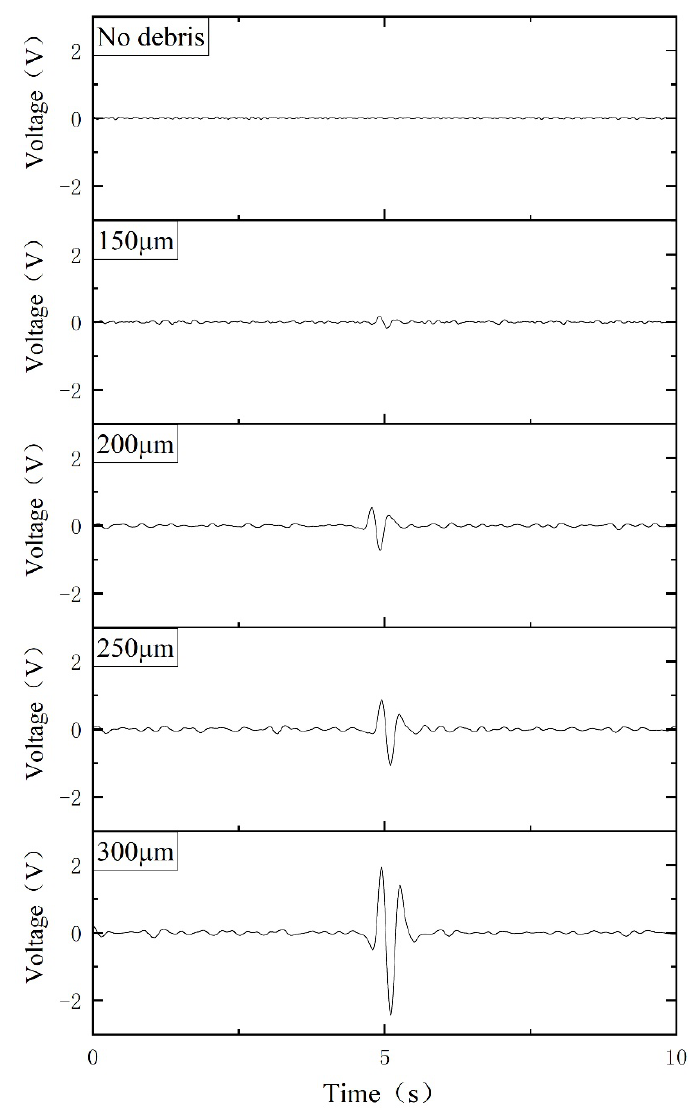
Figure 7. Voltage signals are generated by the passage of ferrous metal debris of different diameters.